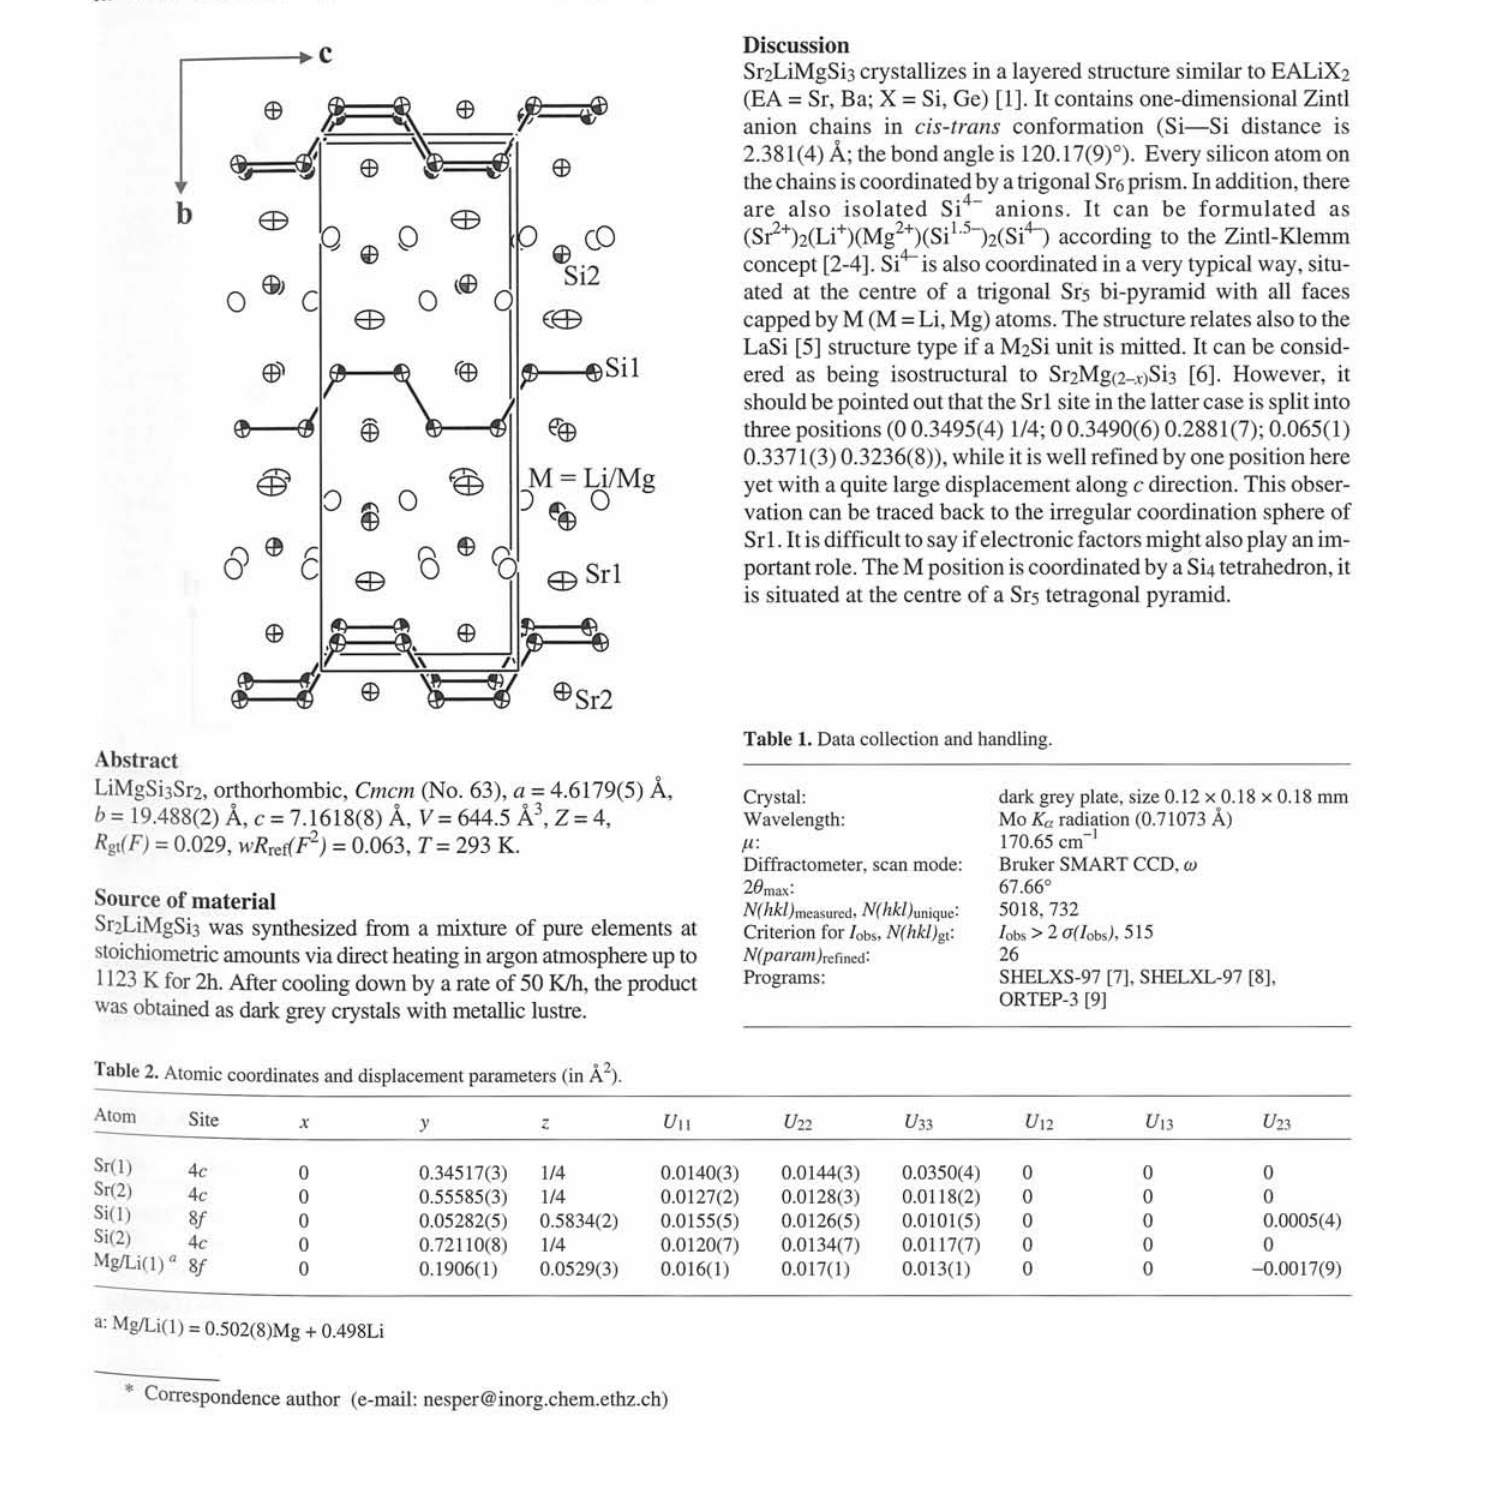
Table 2. Atomic coordinates and displacement parameters (in Á 2 ).